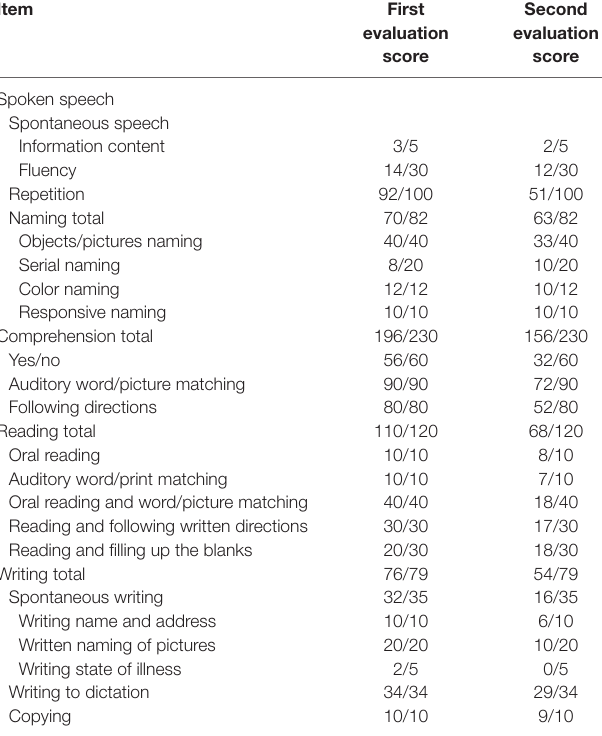
tabLe 1 | Results of longitudinal language evaluating at age 73 and